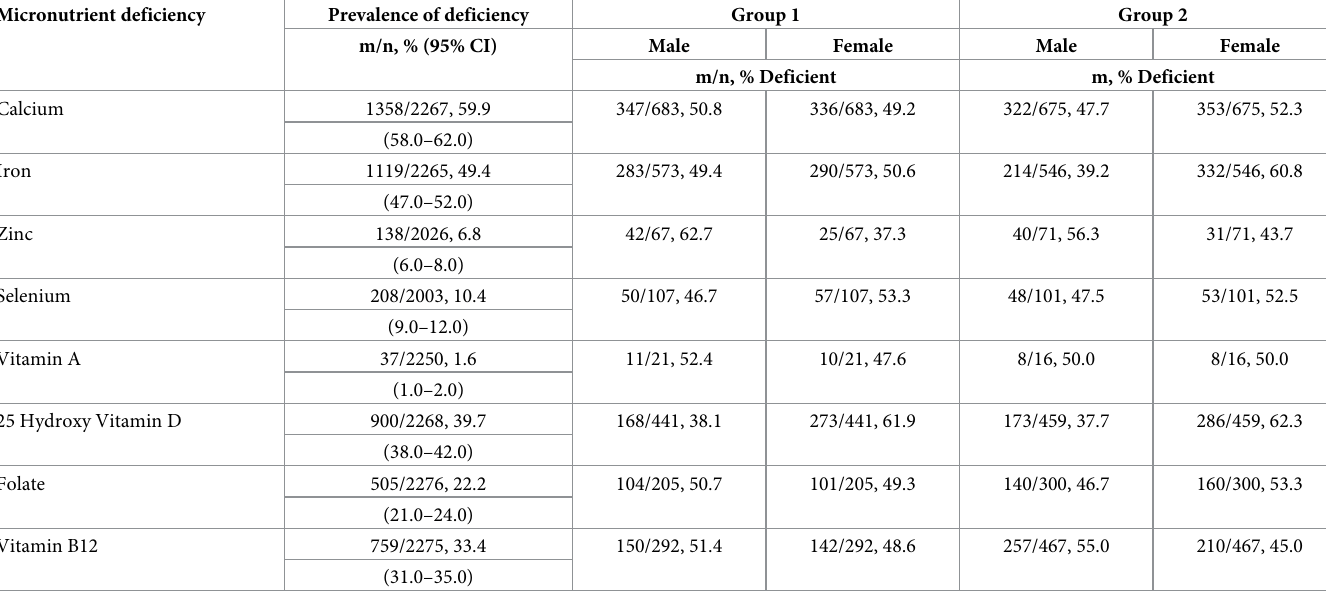
Table 3. Specific micronutrient deficiencies by age group and by gender.